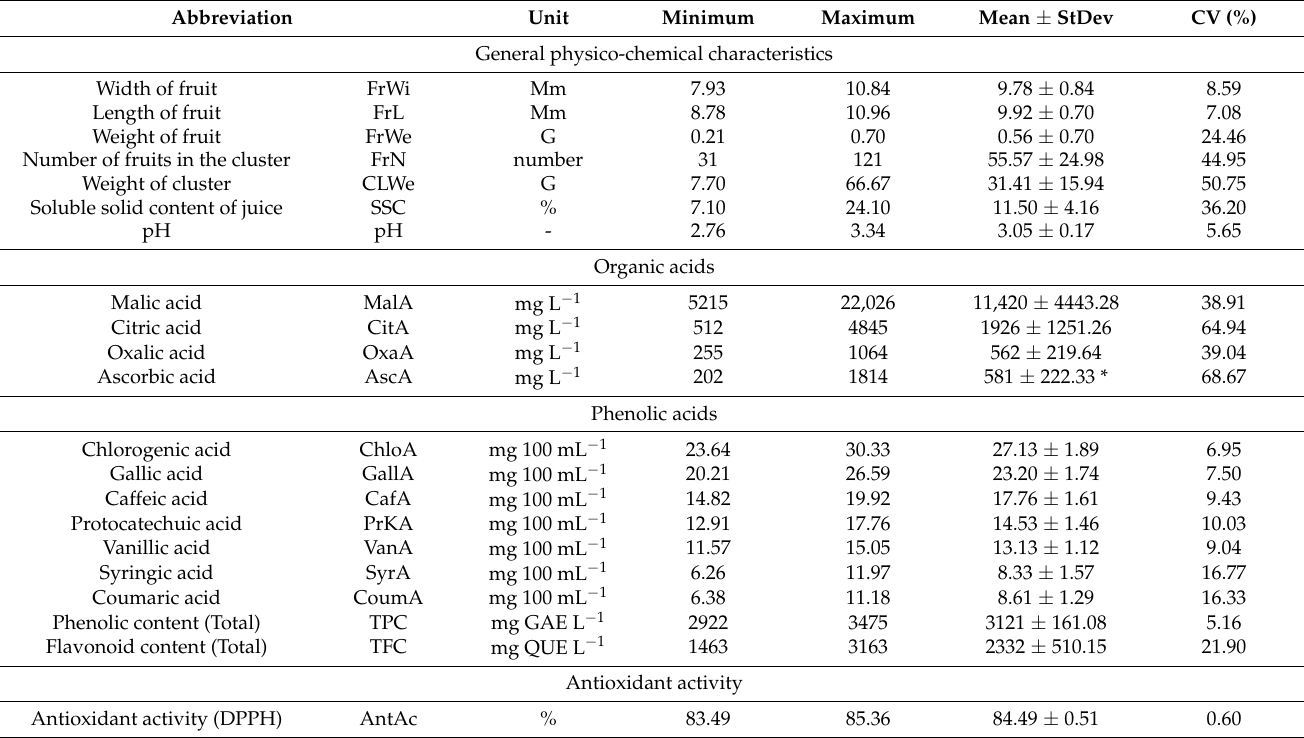
Table 3. Descriptive statistics for physico-chemical